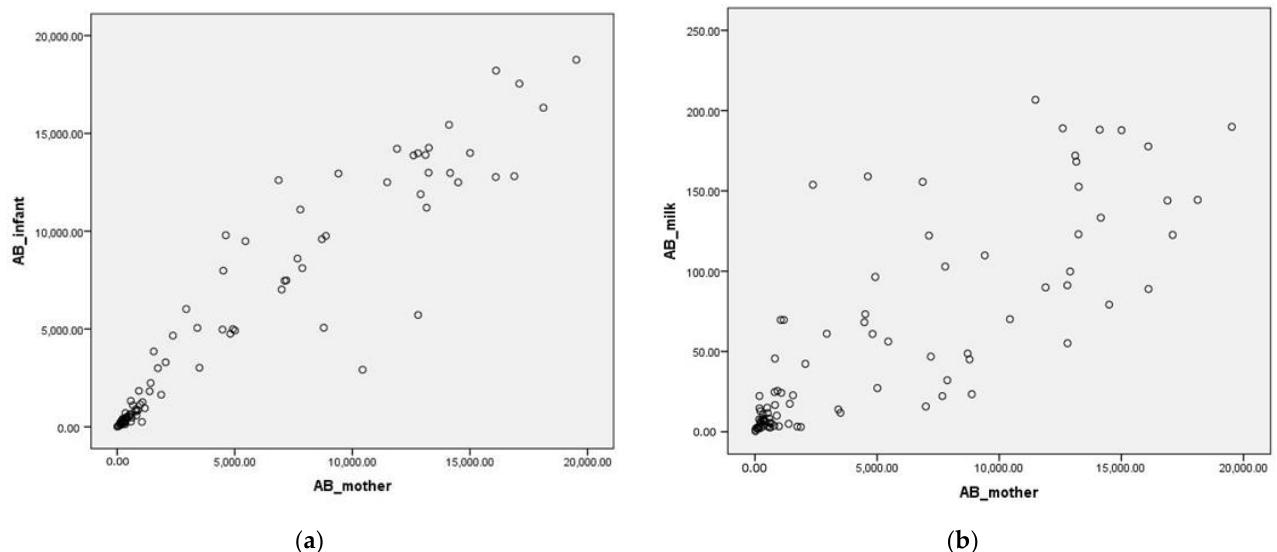
Figure 1. Correlation graph between: ( a ) neutralizing anti-SARS-CoV-2 spike (S) protein antibodies in maternal serum and neonatal serum; The x -axis shows the maternal antibody titer and the y -axis the neonatal antibody titer. ( b ) neutralizing anti-SARS-CoV-2 spike (S) protein antibodies in maternal serum and breastmilk; The x -axis shows the titer of maternal antibodies and the y -axis the titer of breast milk